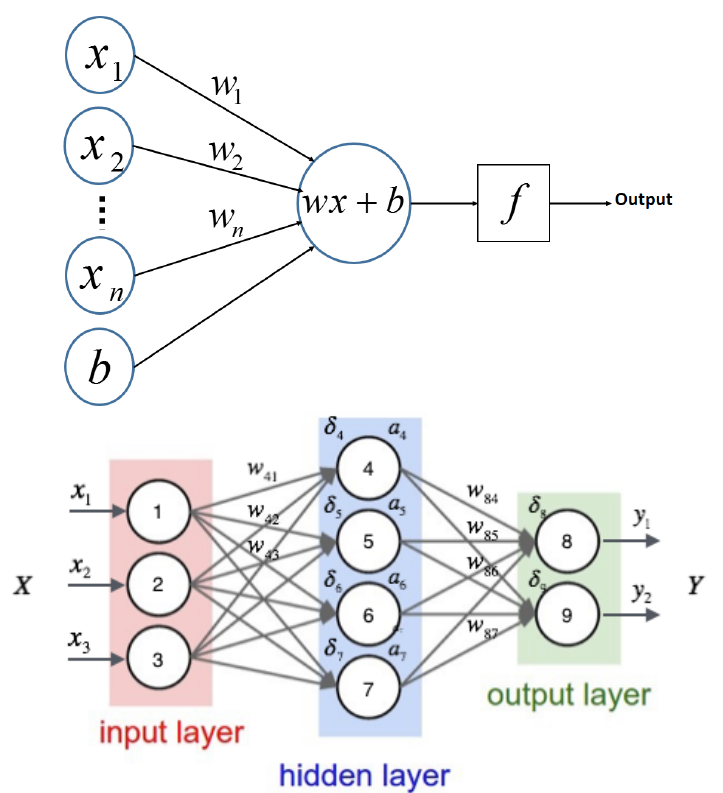
Figure 3. Illustration of a single layer neural network model. The upper and lower subfigures denote the single output and multiple outputs,